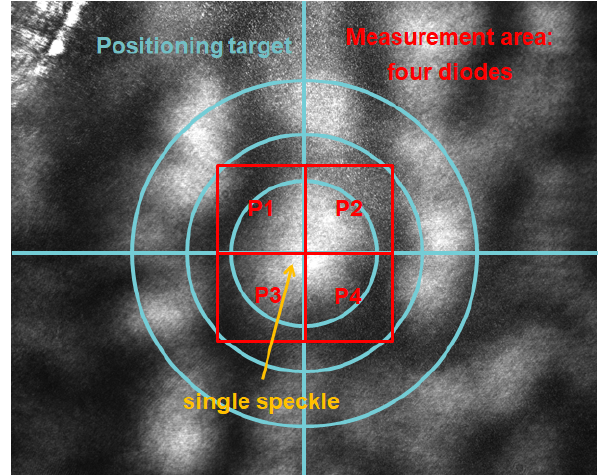
Figure 3. The camera image of an exemplary speckle used for photoacoustic measurement is shown. The speckle is placed in the center of the reference camera (blue target) and thus in the center of four